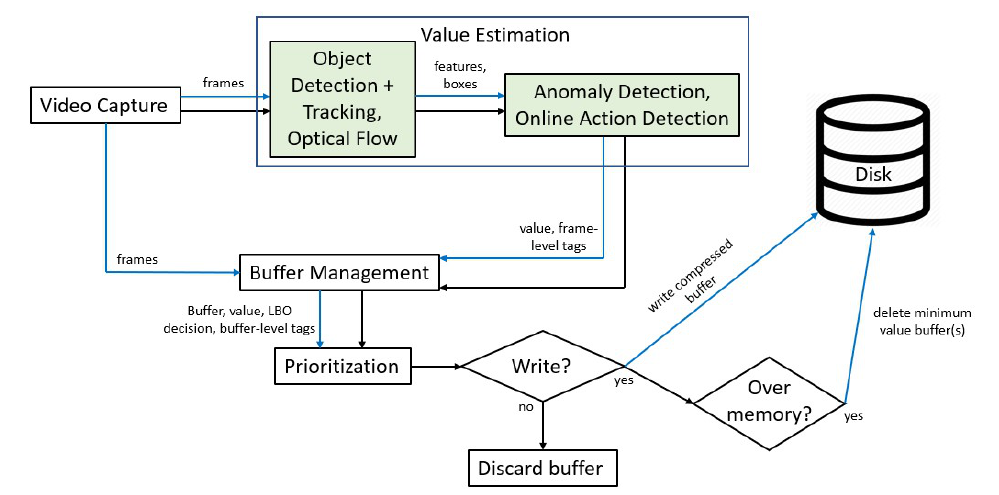
Figure 1. The updated smart black box (SBB) data recording pipeline. Green blocks denote new modules that were not present in the original SBB [13]. Black arrows indicate logic flow, and blue arrows indicate data flow. LBO, local buffer